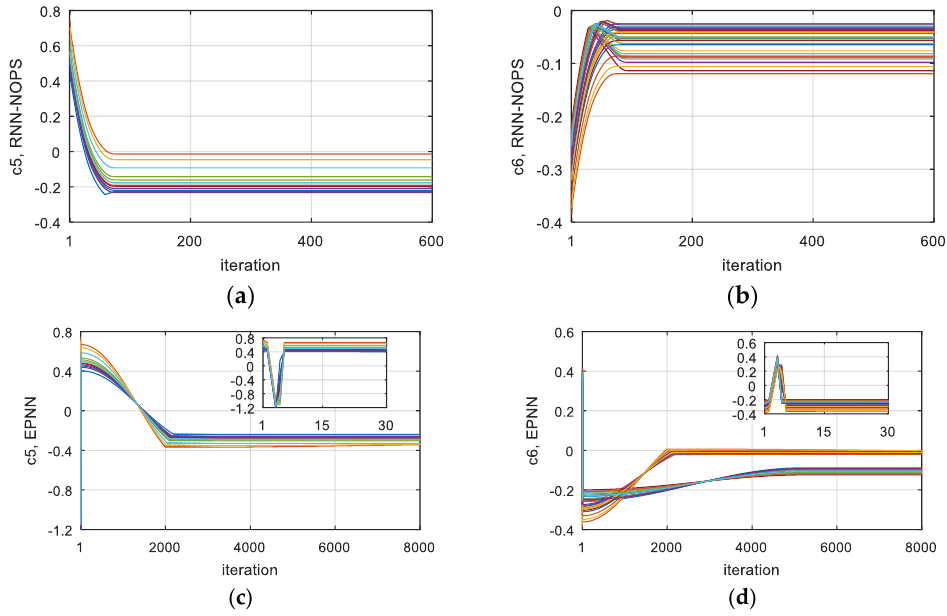
Figure 7. Trajectories during training process of RNN-NOPS and EPNN under SC03 cycle in terms of constraint 5 in ( a ) and ( c ), respectively, and constraint 6 in ( b ) and ( d ), respectively.